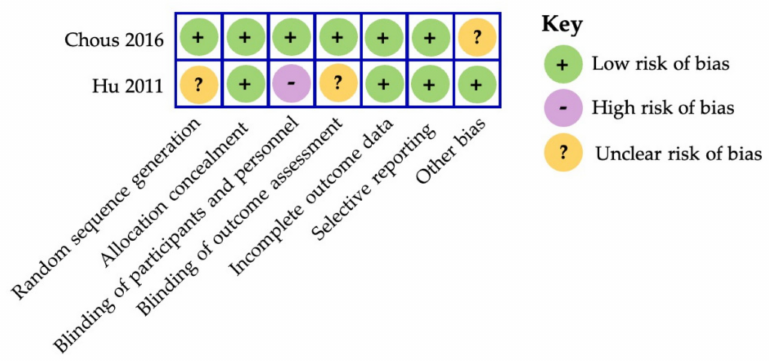
Figure 4. The Cochrane Collaboration’s tool for assessing risk of bias in randomized controlled trials [101].